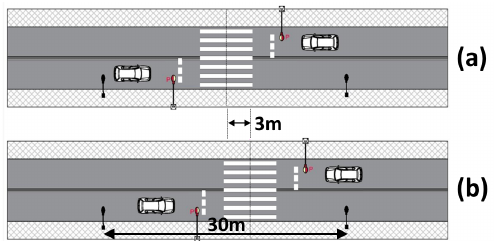
Figure 4. Scenario 1: ( a ) the reference pedestrian crossing, together with dedicated lamps.; ( b ) the crosswalk shifted by 3 m relative to roadway lighting luminaires.